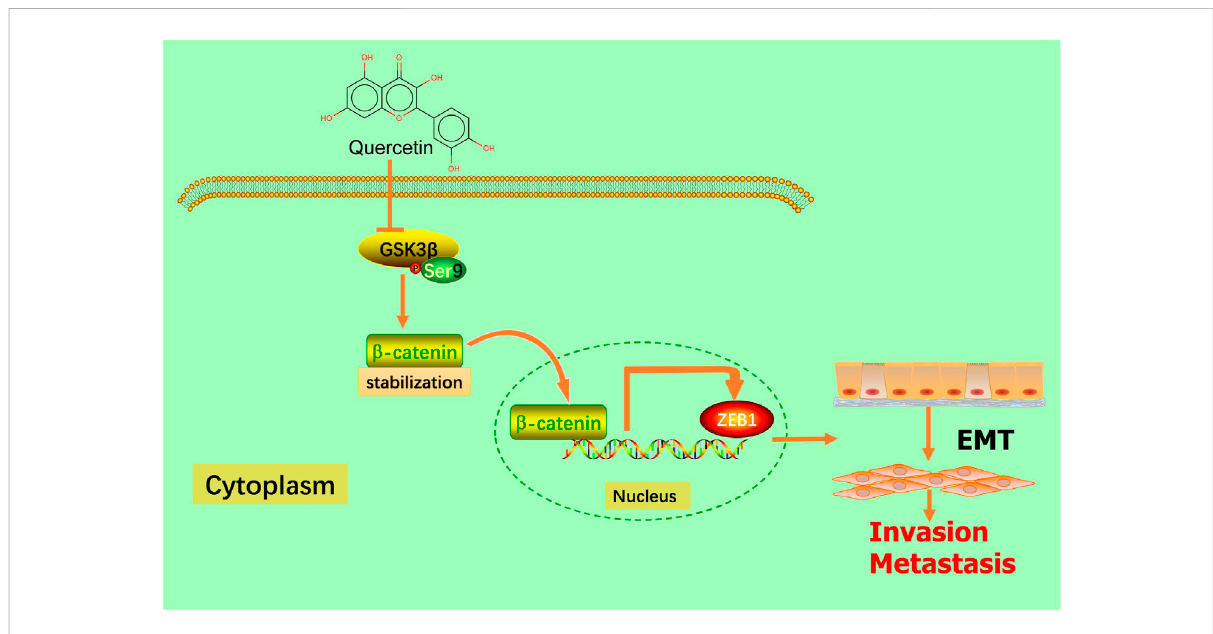
FIGURE 9 Schematic model. Quercetin suppresses invasion and metastasis via GSK-3 β / β -catenin/ZEB1 induced EMT-like mesenchymal transition in human glioblastoma.